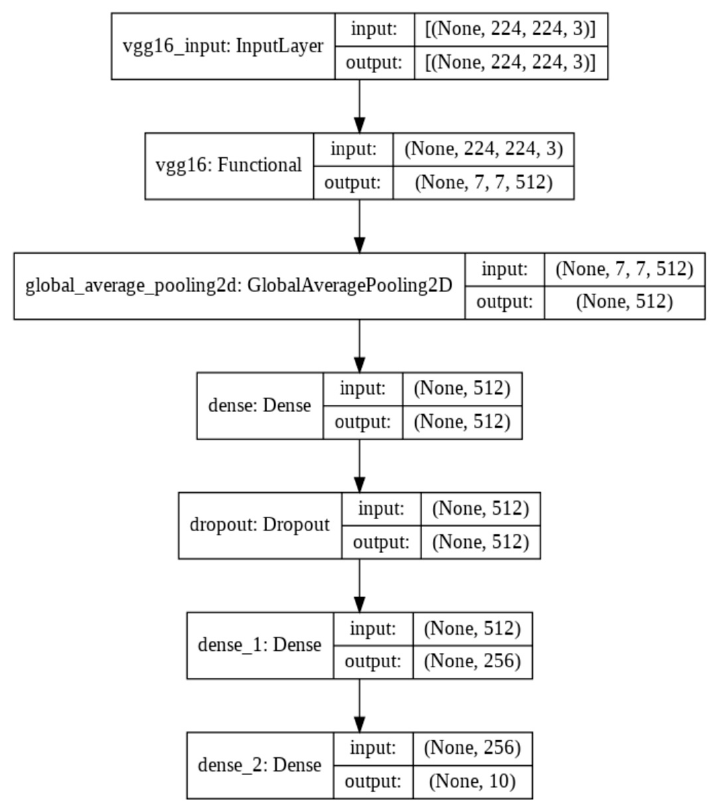
Figure 7. Dense net architecture (VGG16).